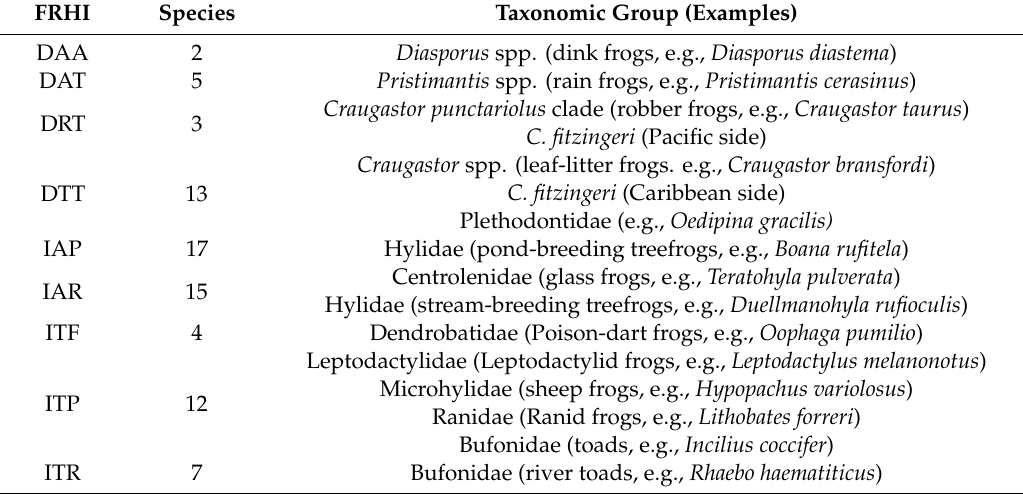
Table 2. Categories and taxonomic examples of the foraging–reproduction habitat index (FRHI) that we developed for this study to analyze current prevalence of Batrachochytrium dendrobatidis across taxonomic groups. Symbology: First letter represents development: (I) indirect- or (D) direct-developing amphibians. Second letter represents foraging habitat: terrestrial (T), arboreal (A) pond / puddle-dwellers (P), stream-breeders (R), and phytotelma (F). Third letter represents reproductive habitat: terrestrial (T), arboreal (A), pond / puddle-dwellers (P), stream-breeders (R), and phytotelma (F).